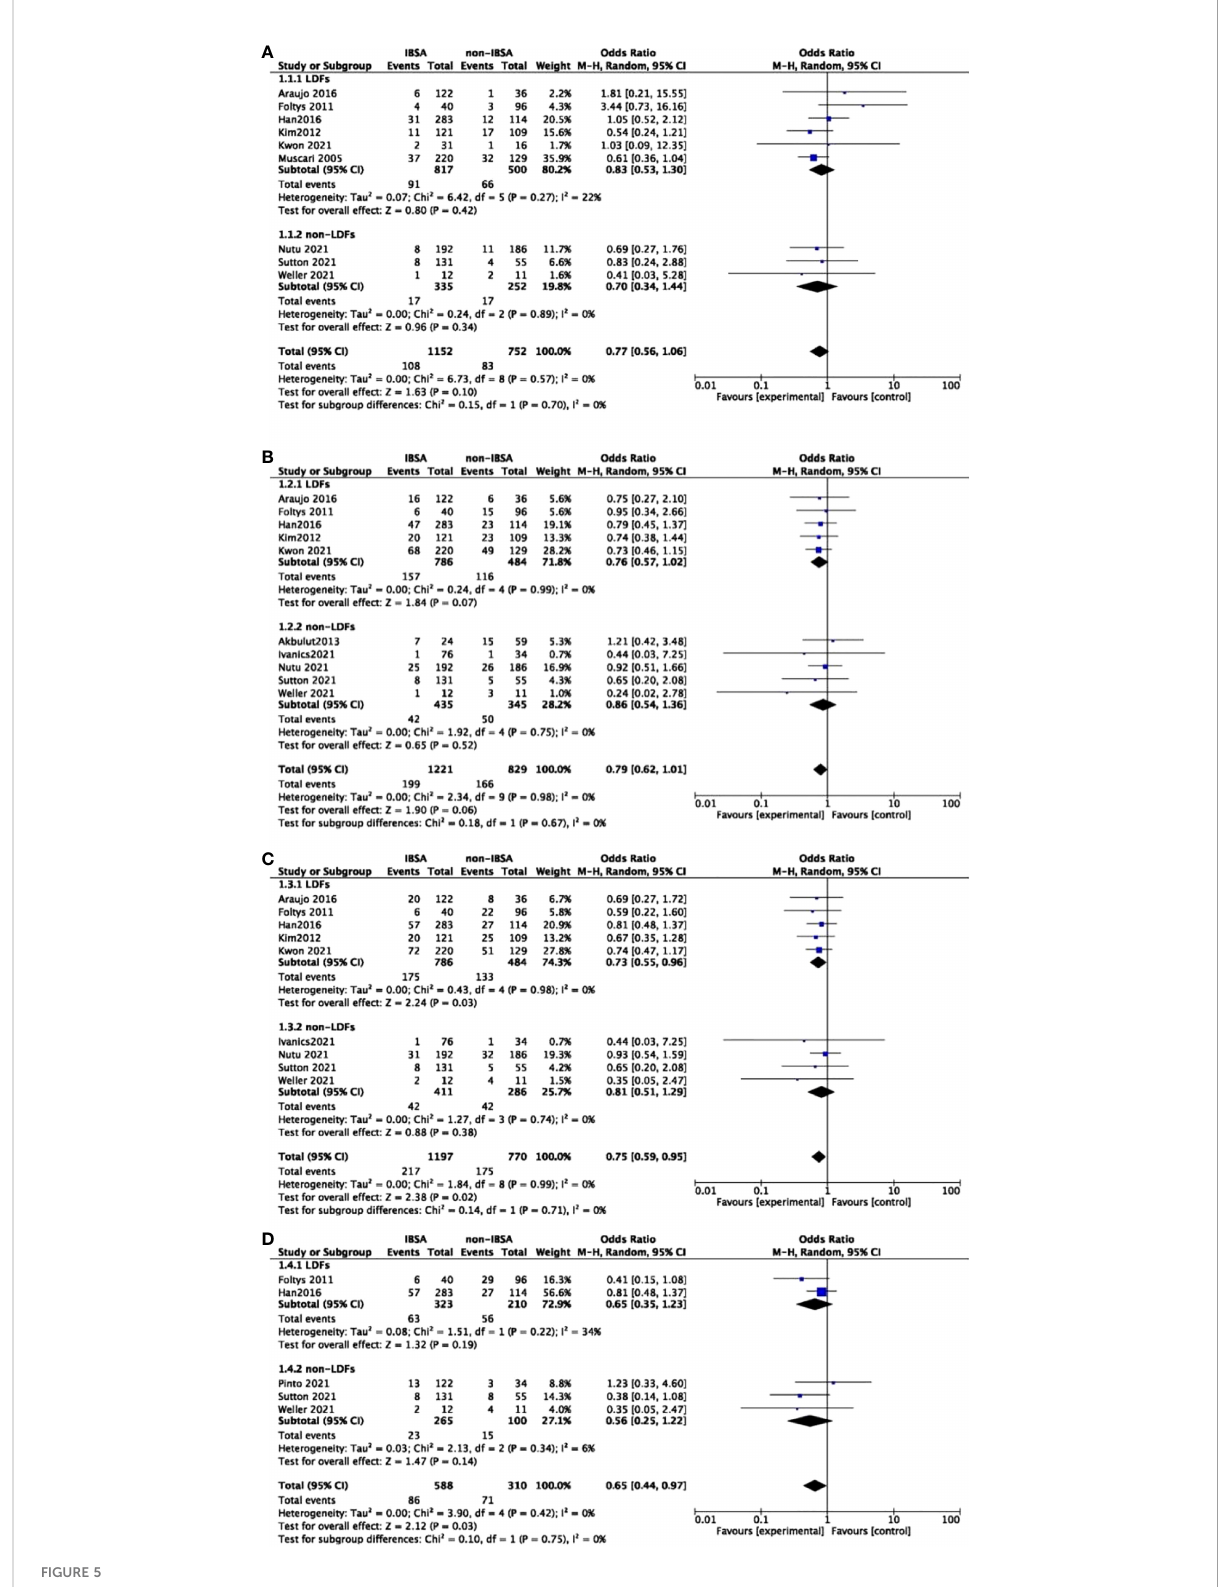
FIGURE 5 Meta-analysis forest plot of subgroup analysis of the recurrence rate. (A) , 1-year RR; (B) , 3-year RR; (C) , 5-year RR; (D) , 7-year